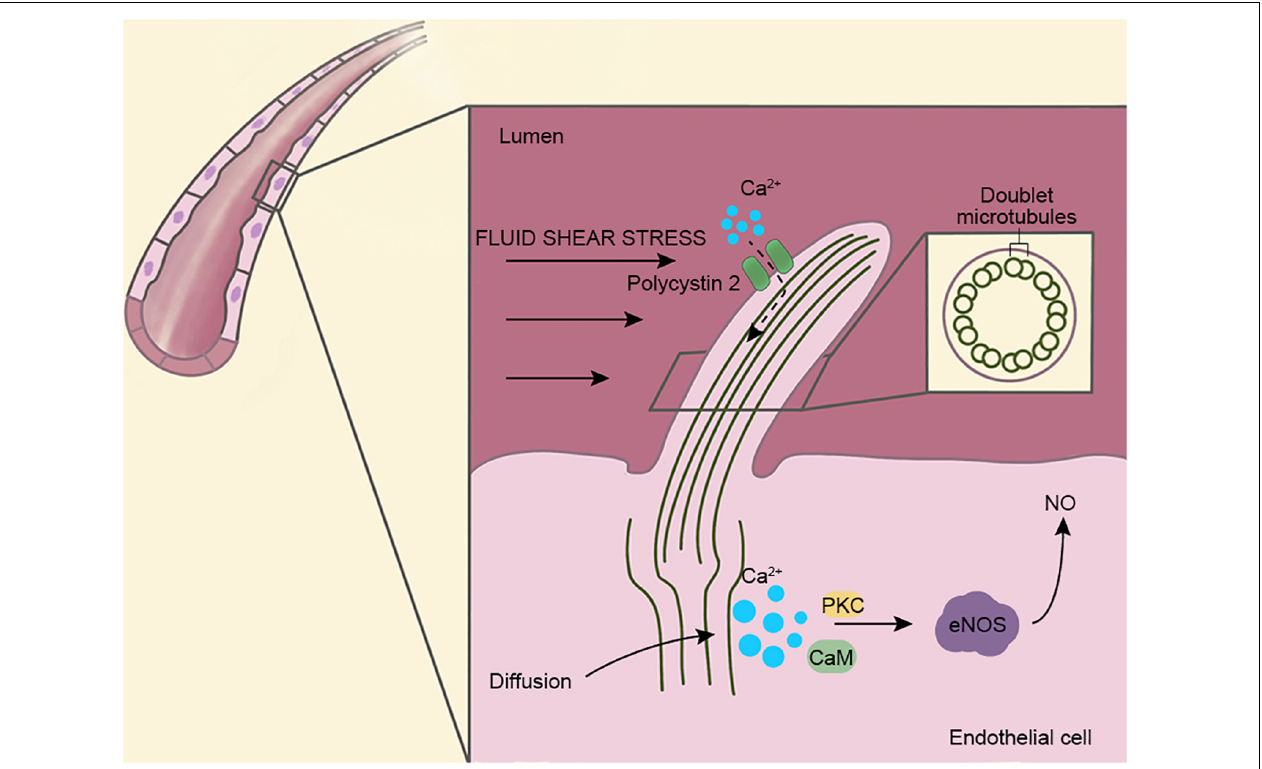
FIGURE 1 | Structure and function of vascular endothelial cilia. Primary cilia are present on the surfaces of vascular endothelial cells and extend into the lumen. Cilia are used as mechanoreceptors and signaling centers to regulate vascular functions. The ciliary axenome is composed of nine pairs of doublet microtubules and surrounded by a ciliary membrane, where several transport proteins and ion channels are present. Fluid shear stress is known to open Ca 2 + channels on cilia (dotted line), but recent studies show that Ca 2 + originates in the cytoplasm instead of cilia. Via the actions of protein kinase C (PKC) and calmodulin (CaM), endothelial nitric oxide synthase (eNOS) is activated and leads to the upregulation of NO, which dilates blood vessels and prevents vascular rupture caused by excessive blood